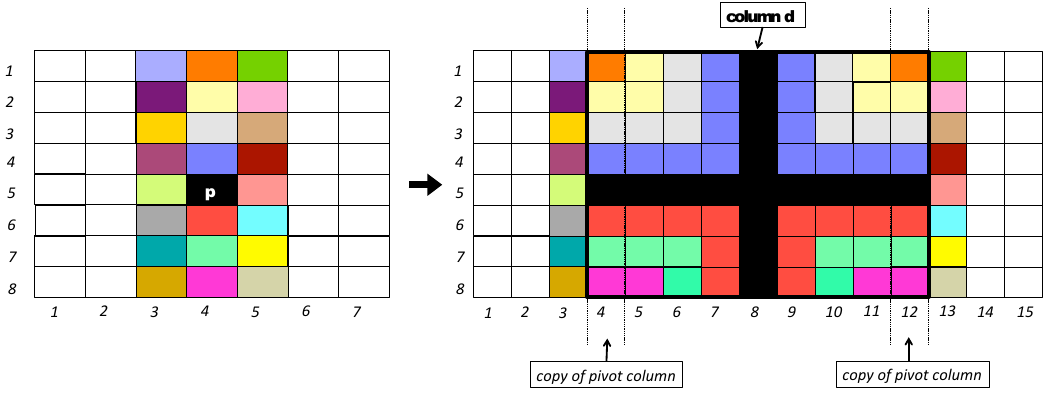
Fig. 2: Transformation of an 8 × 7 grid into an equivalent